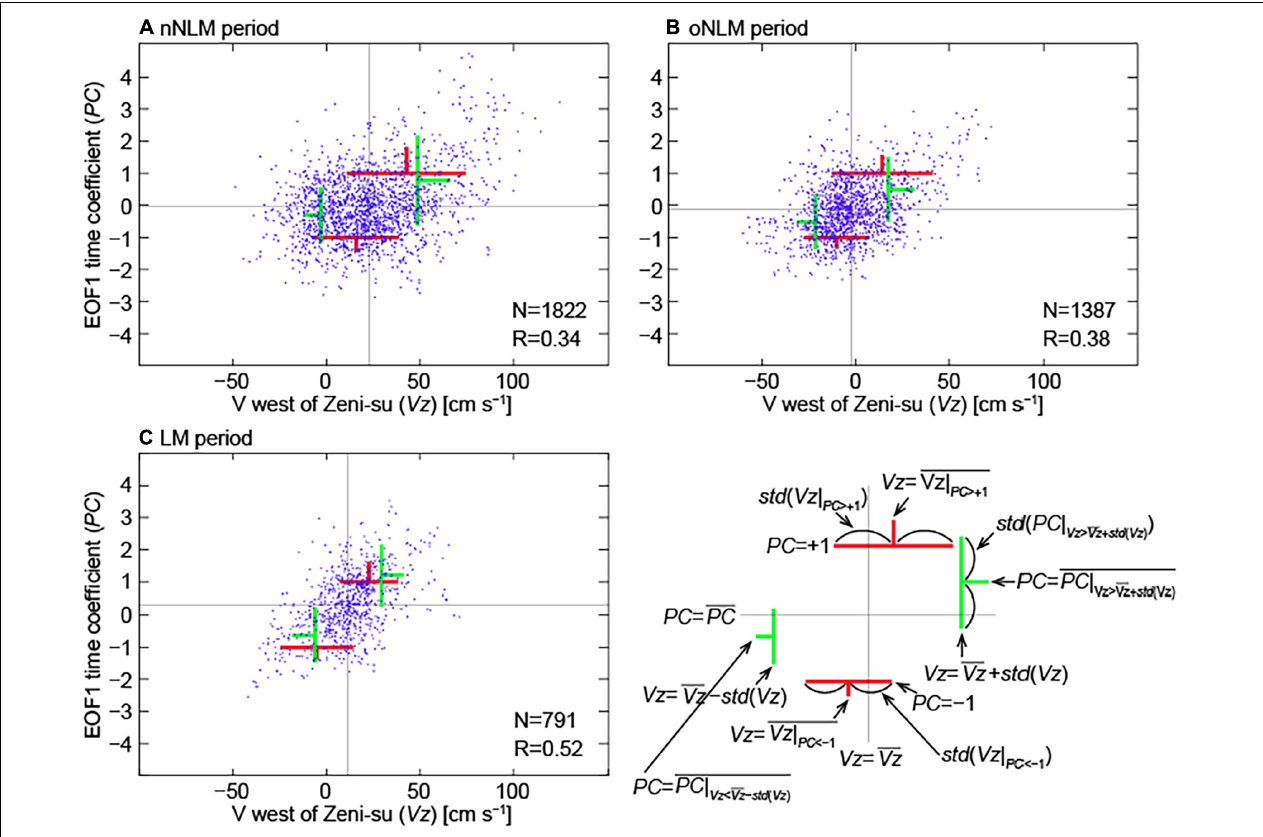
FIGURE 13 | Scatter diagrams between meridional velocity to the west of Zeni-su ( Vz ) and EOF1 time coefficient ( PC ) during the individual Kuroshio path period. (A) nNLM. (B) oNLM. (C) LM. Meridional velocities to the west of Zeni-su at 100 m depth were averaged along the 33.95 ◦ N line over 138.3 ◦ E–138.6 ◦ E (A) , 138.15 ◦ E–138.45 ◦ E (B) , 137.75 ◦ E–138.15 ◦ E (C) based on the differences of the positive and negative composites during the individual periods ( Figure 6 ). Lags of PC from Vz by 1, 4, and 3 days for (A–C) , respectively, were considered to represent maximum correlations (R). Averages (denoted by overbar) and standard deviations (“ std ”) of Vz values when PC < − 1 and PC > +1 are indicated by red segments. Similarly, averages and standard deviations of PC values when Vz < Vz − std ( Vz ) and when Vz > Vz + std ( Vz ) are indicated by green